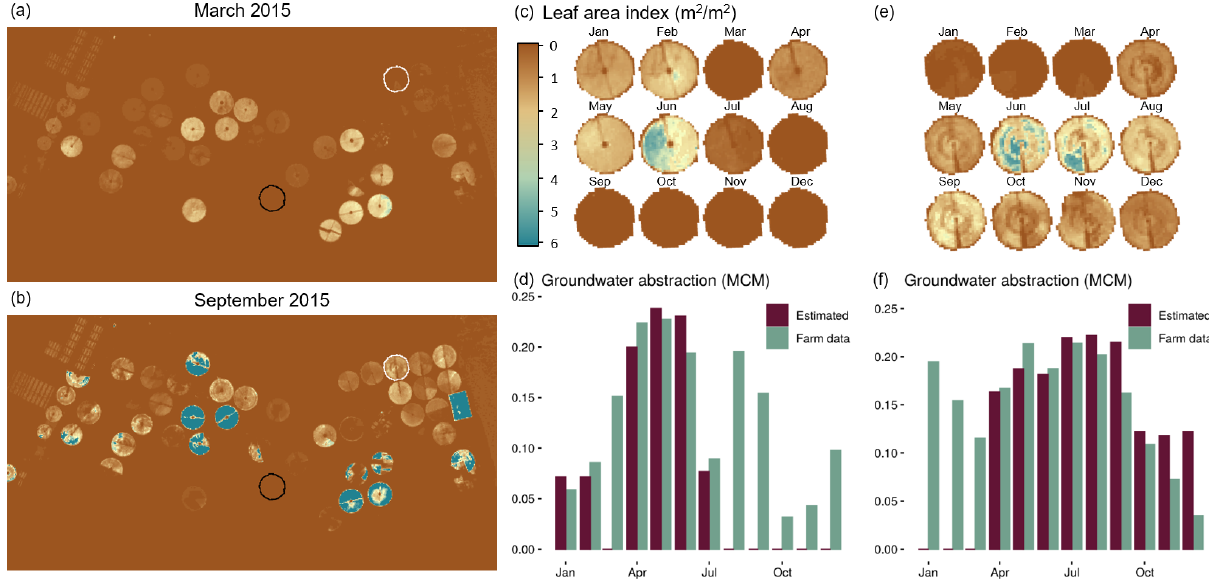
Figure 6. Estimated groundwater abstraction in million cubic meters (MCM) for two fields in the Tawdeehiya farm along with a comparison based on available flow rates from farm data. (a, b) show the spatial maps of LAI data (m 2 m − 2 ) using the methodology described in Sect. 3.1. Two fields from two different periods are delineated either in black (corresponding to c , d ) or white (e, f) . (c, e) show a spatiotemporal map of LAI for the two fields, while (d, f) show a comparison of groundwater abstraction obtained using the framework described in Sect. 3 and available farm data. The field marked with black is one of the 11 fields identified as having a large abstraction discrepancy; i.e., the farm data indicate ongoing periods of irrigation, while the LAI data indicate